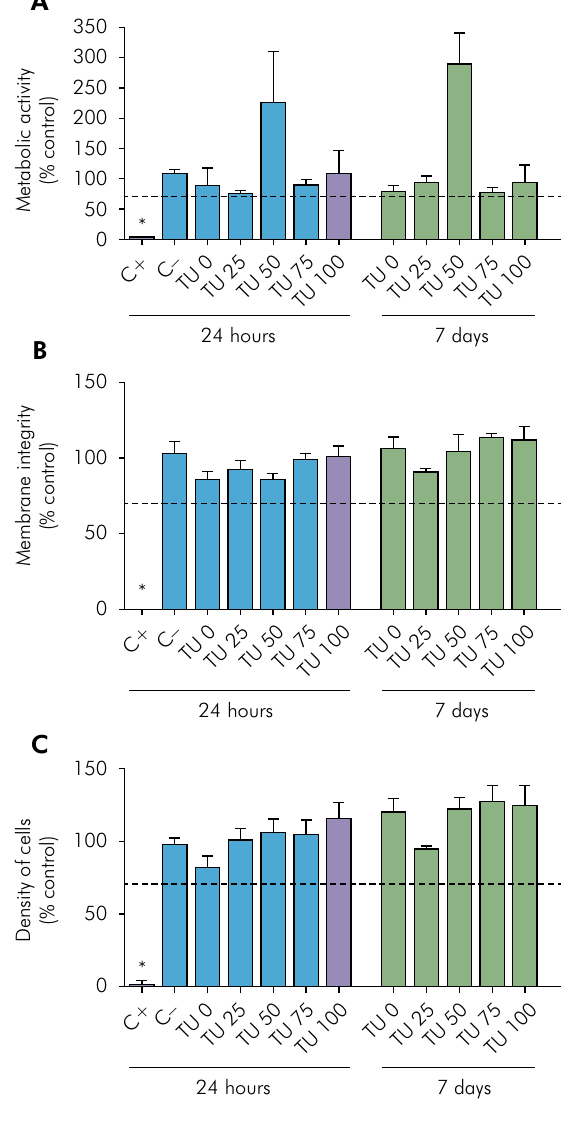
Figure 2. Multiparametric Cytotoxicity Assay. HGF cells were exposed to extracts produced by incubation for 24h (black bars) or 7 days (white bars) of each material, or to a positive control (Latex, C+), or a negative control (Polystyrene beads, C-). Cell survival was measured by the XTT (A), NRU (B), or CVDE (C) assays. Results represented as mean±SD of quintuplicates, as a percentage of an unexposed group (Control). The dashed line identifies the cutoff of 70% cell survival for non-cytotoxic materials, according to ISO 7405:2008. The asterisk indicates significant difference from all other groups (p <